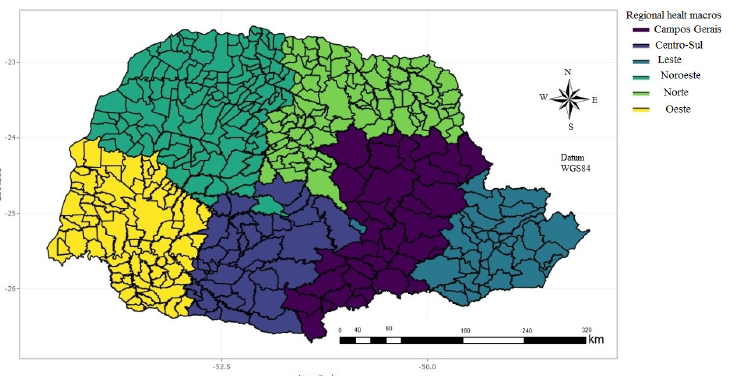
Figure 1. Location map of the Paraná Health macro −